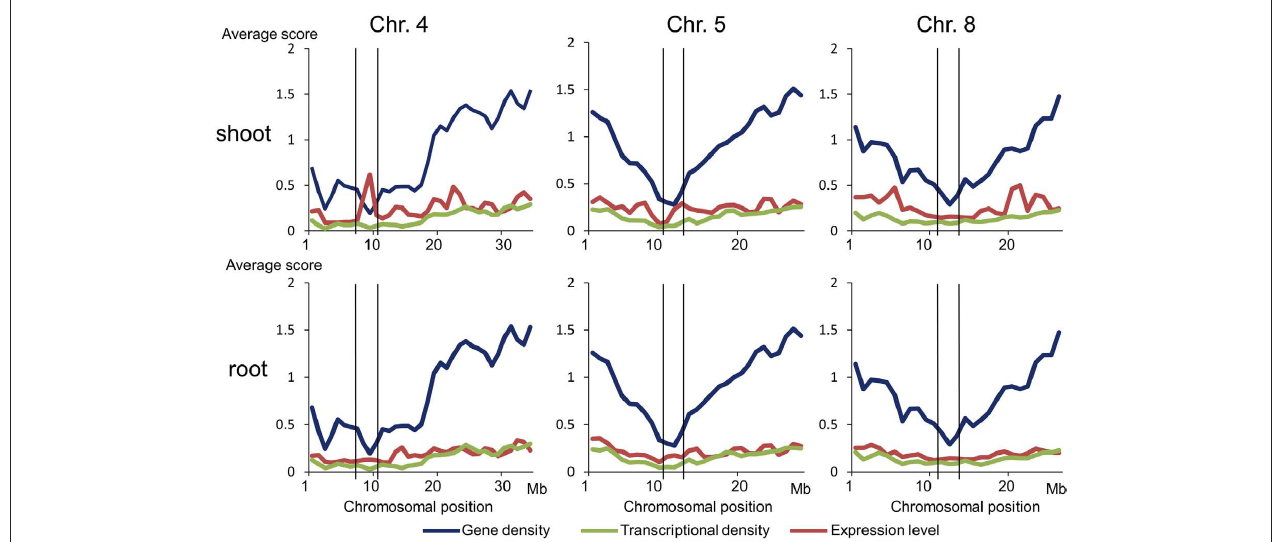
FIGuRe 3 | Relationships of gene density, transcriptional density, and expression levels. Average scores of gene density, transcriptional density, and expression level in each 1 Mb of sliding windows on chromosomes 4, 5, and 8 are shown. Horizontal axis indicates position on the reference rice genome (Build 5.0 pseudomolecules) constructed by the International Rice Genome Sequencing Project. Lines indicate the boundaries of each